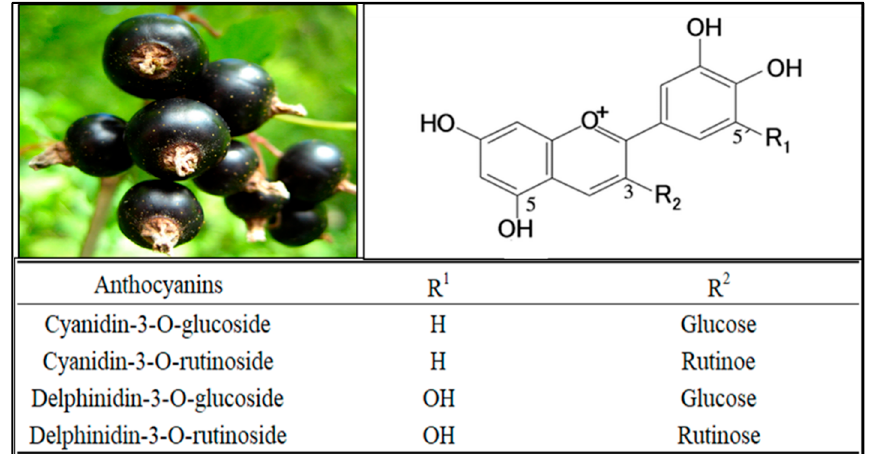
Figure 2. The structures of the major anthocyanins in blackcurrants including cyanidin-3-O-glucoside, cyanidin-3-O-rutinoside, delphinidin-3-O-glucoside, and delphinidin-3-O-rutinoside. The other minor anthocyanins that were identified in various blackcurrant cultivars using HPLC-DAD-MS included the 3-O-glucosides and the 3-O-rutinosides of pelargonidin, cyanidin, peonidin, delphinidin, petunidin, malvidin, cyanidin 3-O-arabinoside, and the 3-O-(6 (cid:48)(cid:48) -p-coumaroylglucoside)s of cyanidin and delphinidin